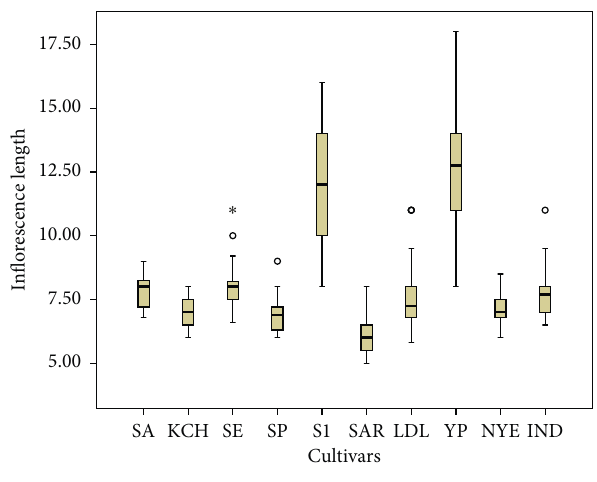
Figure 5: Inflorescence length (cm).